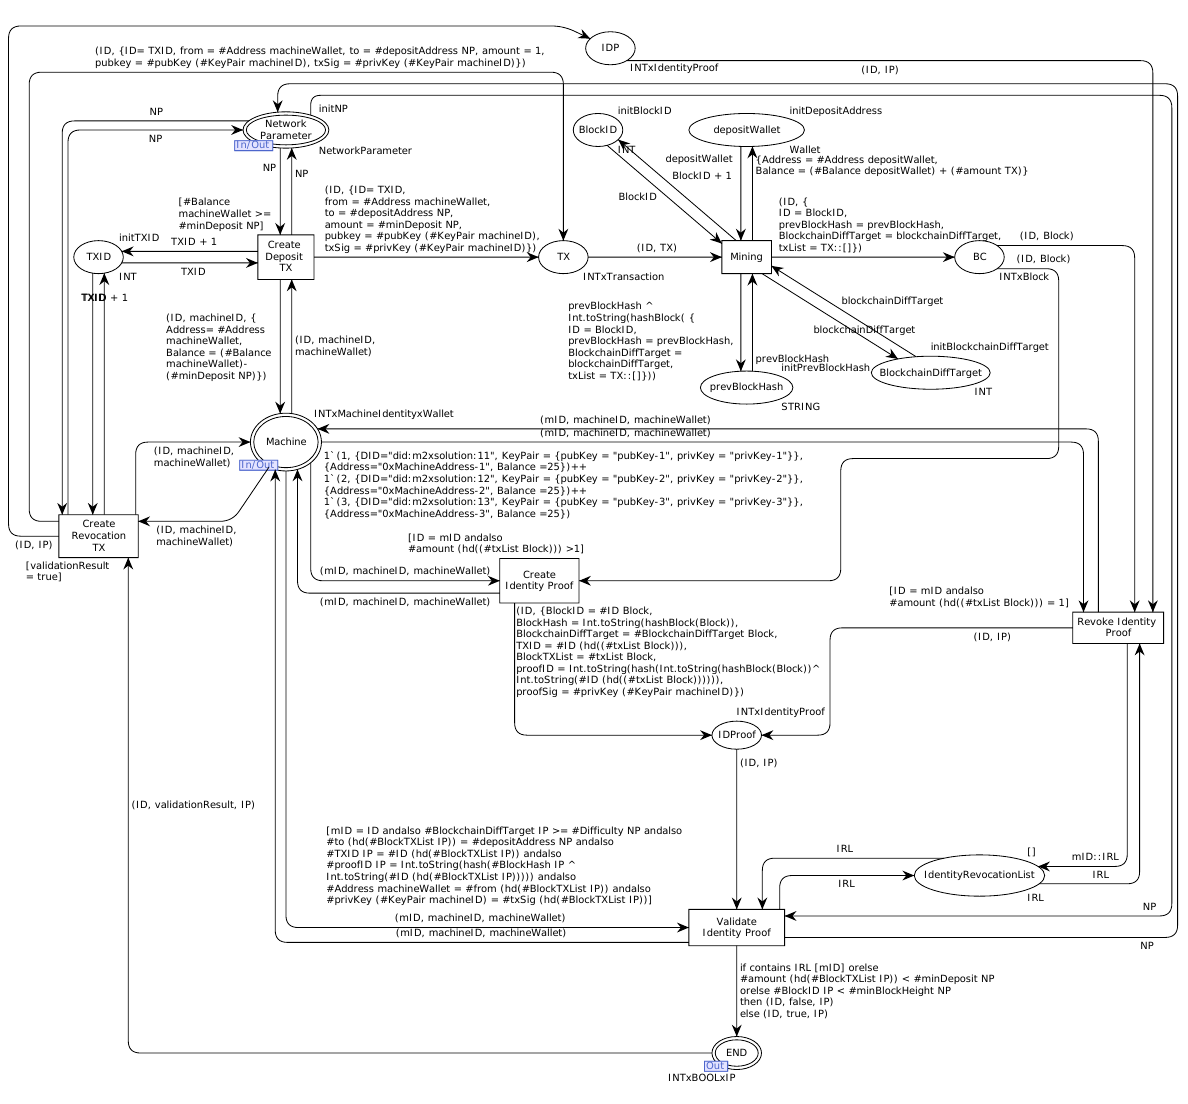
Figure 8. Rechained CPN model—extension of [5]. The CPN model consists of six transitions that are derived from the five sub-goals of the top-level AOM goal model. The protocol flow starts on the left-hand side of Figure 8 with the Create deposit transaction -transition. An infrastructure provider, user, or